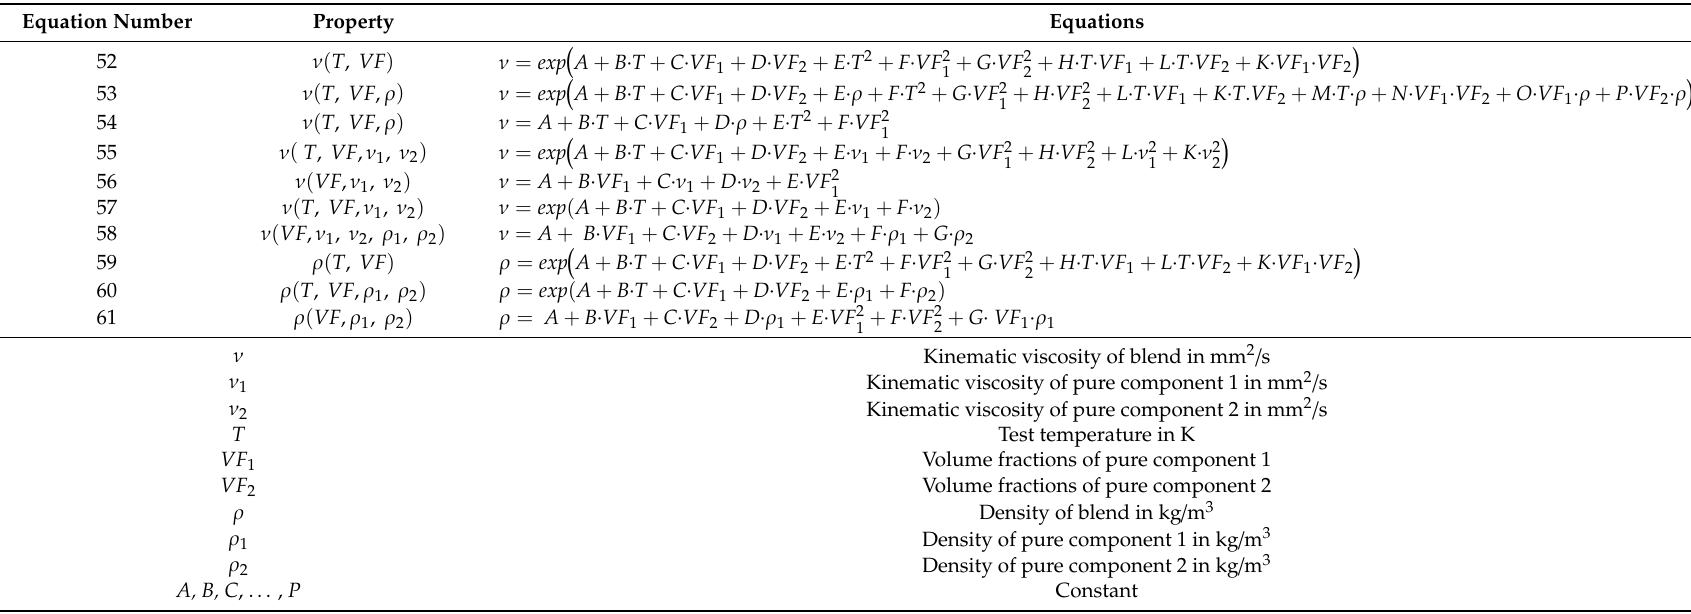
Table 12. Mathematical equations developed by the